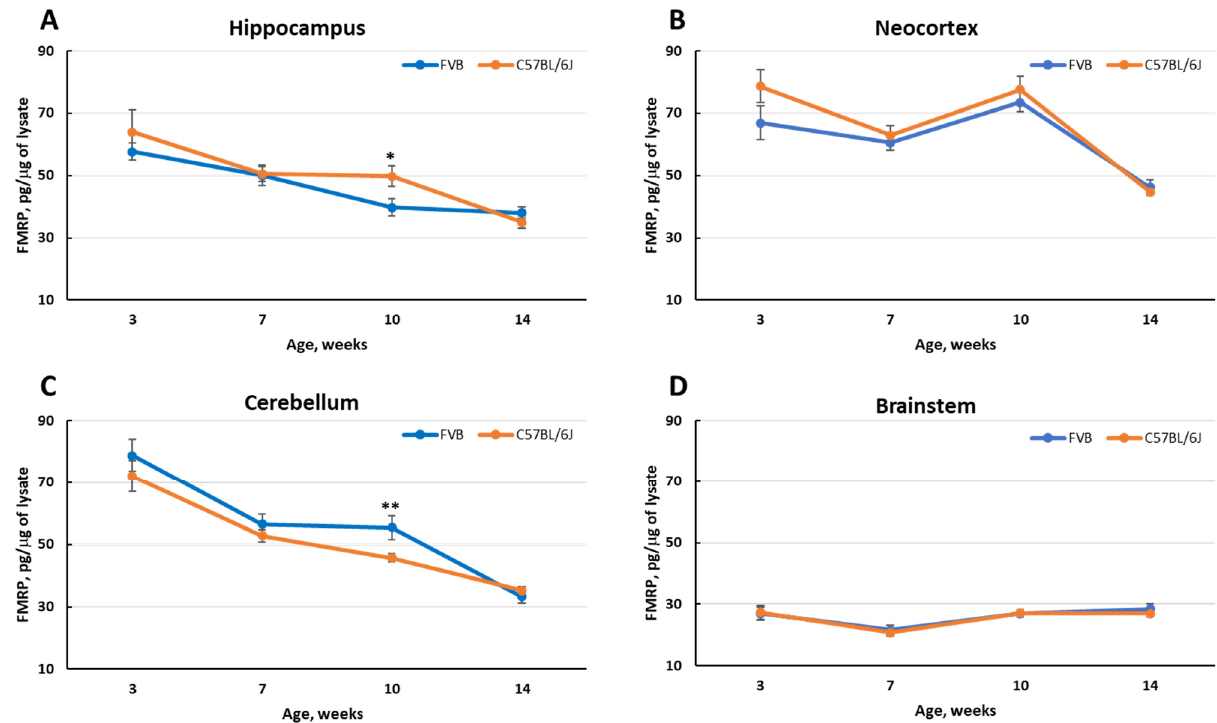
Figure 4. The developmental expression of FMRP in the CNS from 3 to 14 weeks of age in FVB and C57BL/6J mice. The expression of FMRP is illustrated in ( A ). hippocampus; ( B ). neocortex; ( C ). cerebellum, and ( D ). brainstem. Mean presented at 3 weeks of age differential expression of FMRP among the structures: cerebellum > neocortex > hippocampus > brainstem was present in both mouse strains examined. In each strain there was a significant decrease in FMRP expression in both the hippocampus and cerebellum from age 3-14 weeks ( p < 0.001). A significant decrease in FMRP expression in the neocortex did not appear until week 14 ( p < 0.001) compared to 3 weeks. At all ages examined the expression of FMRP in the brainstem remained stable. At 10 weeks of age there was a significant difference in the expression of FMRP in the hippocampus (*— p < 0.03) and the cerebellum (**— p < 0.002) between the strains.